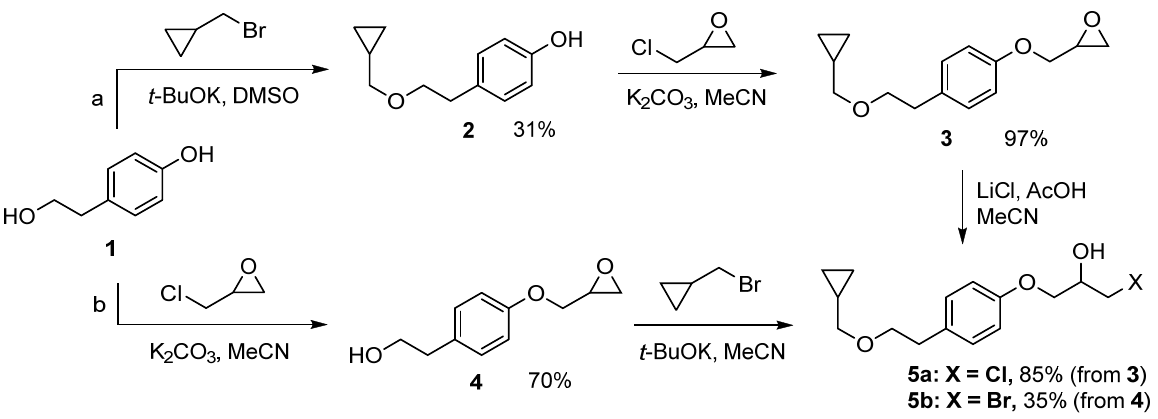
Figure 2. Suggested model for the faster-reacting enantiomer, the R -form, of the general substrate 1-O-alkyl-2-alkanol, in the active site of CALB [19].